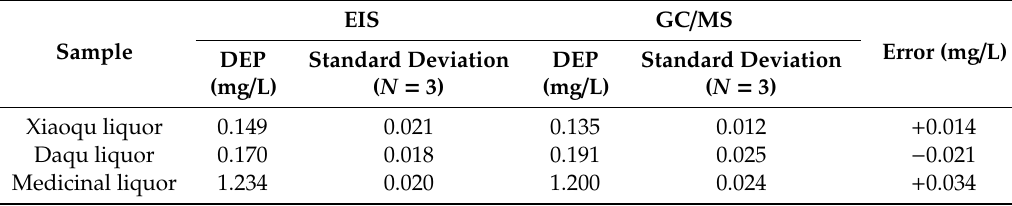
Table 2. The comparison of DEP analysis in real liquor samples with GC / MS and EIS methods.